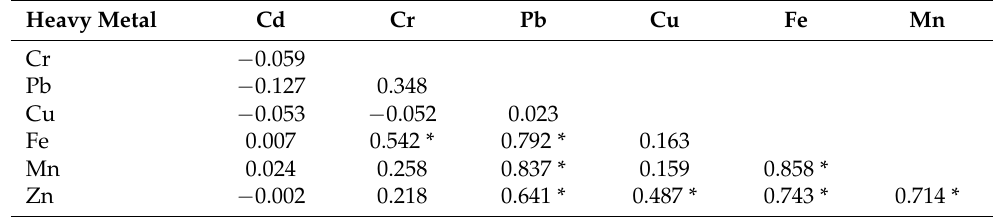
Table 2. Pearson correlation among different heavy metals studied from different sampling sites. Heavy